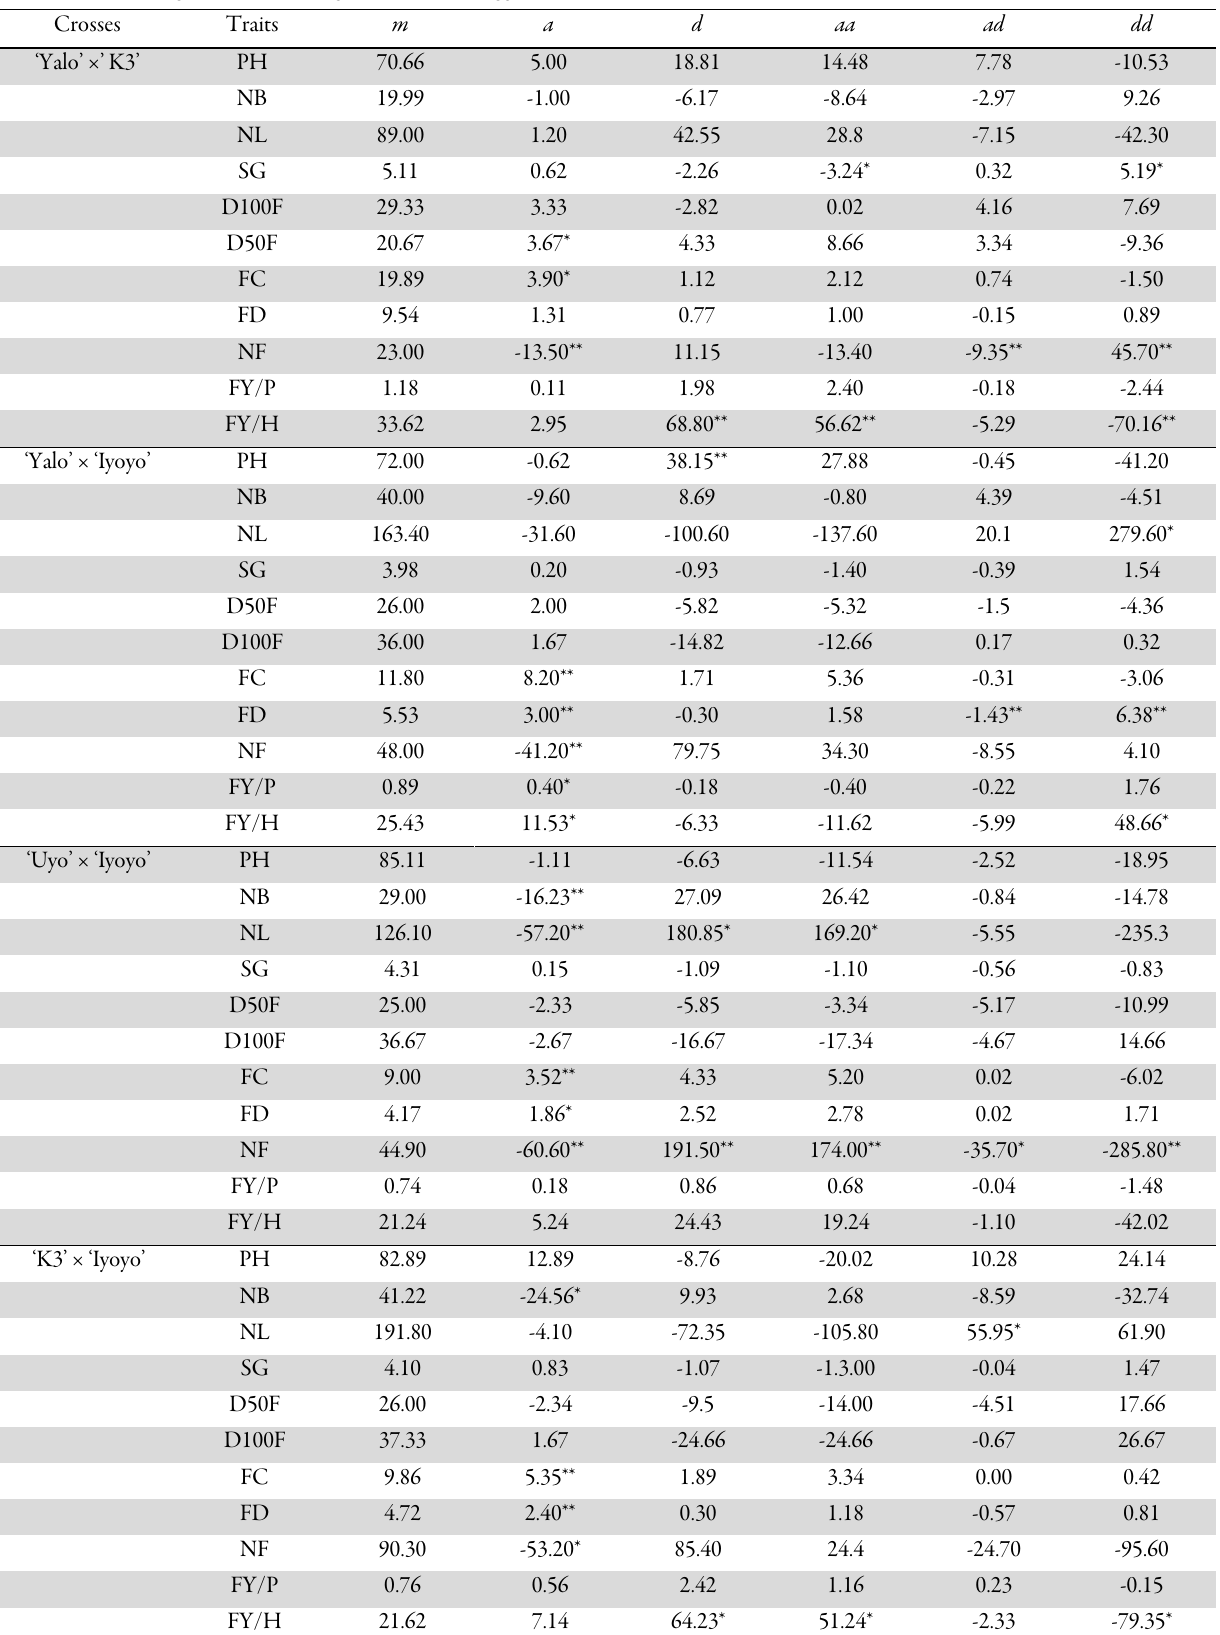
Table 3. Estimates of gene effects for 11 agronomic traits in eggplant Crosses Traits m ‘Yalo’ ×’